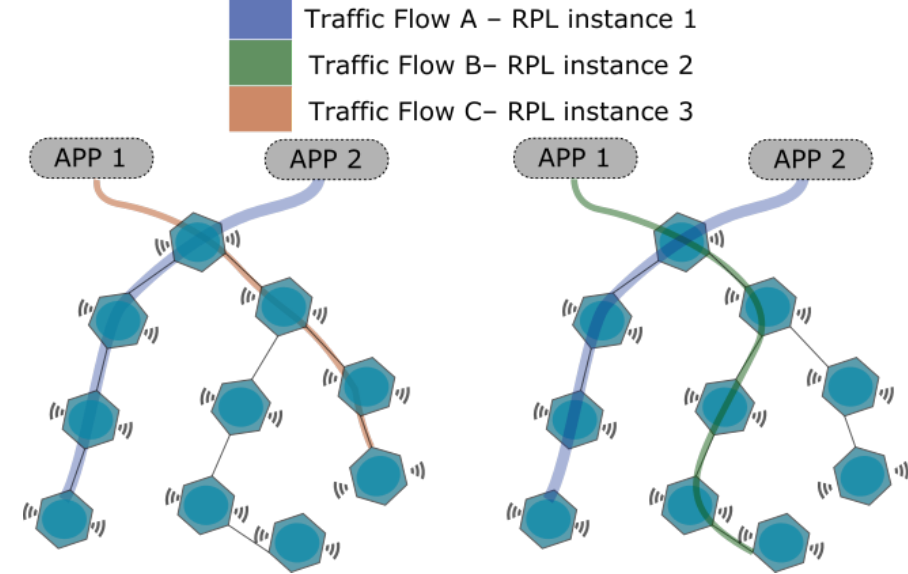
Figure 1. Diagram of the linkage between applications, instances, and traffic